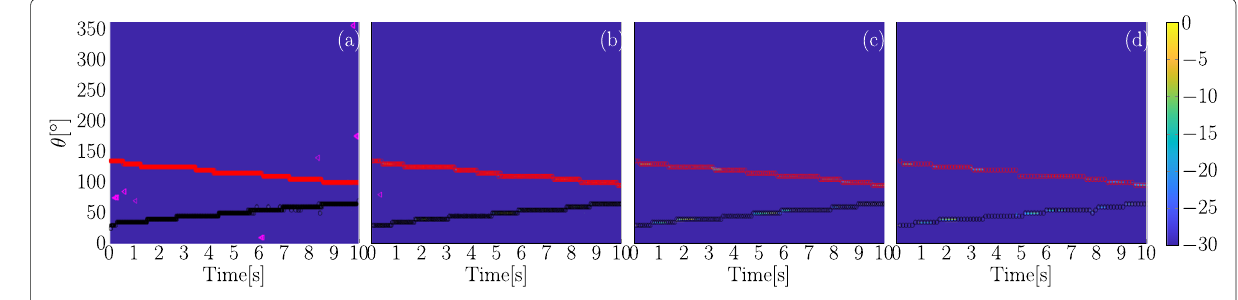
Fig. 11 The performance of the proposed method versus different number of snapshots L in a frame. a L = 1. b L = 5. c L = 10. d L =